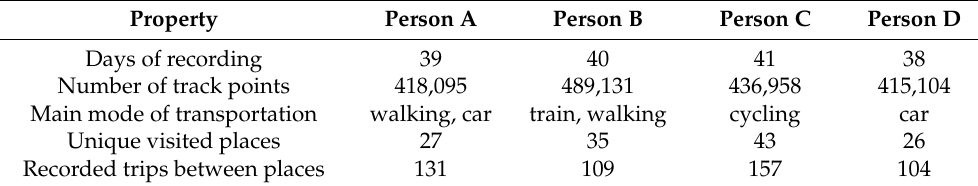
Table 2. Details of ground truth datasets for four trial